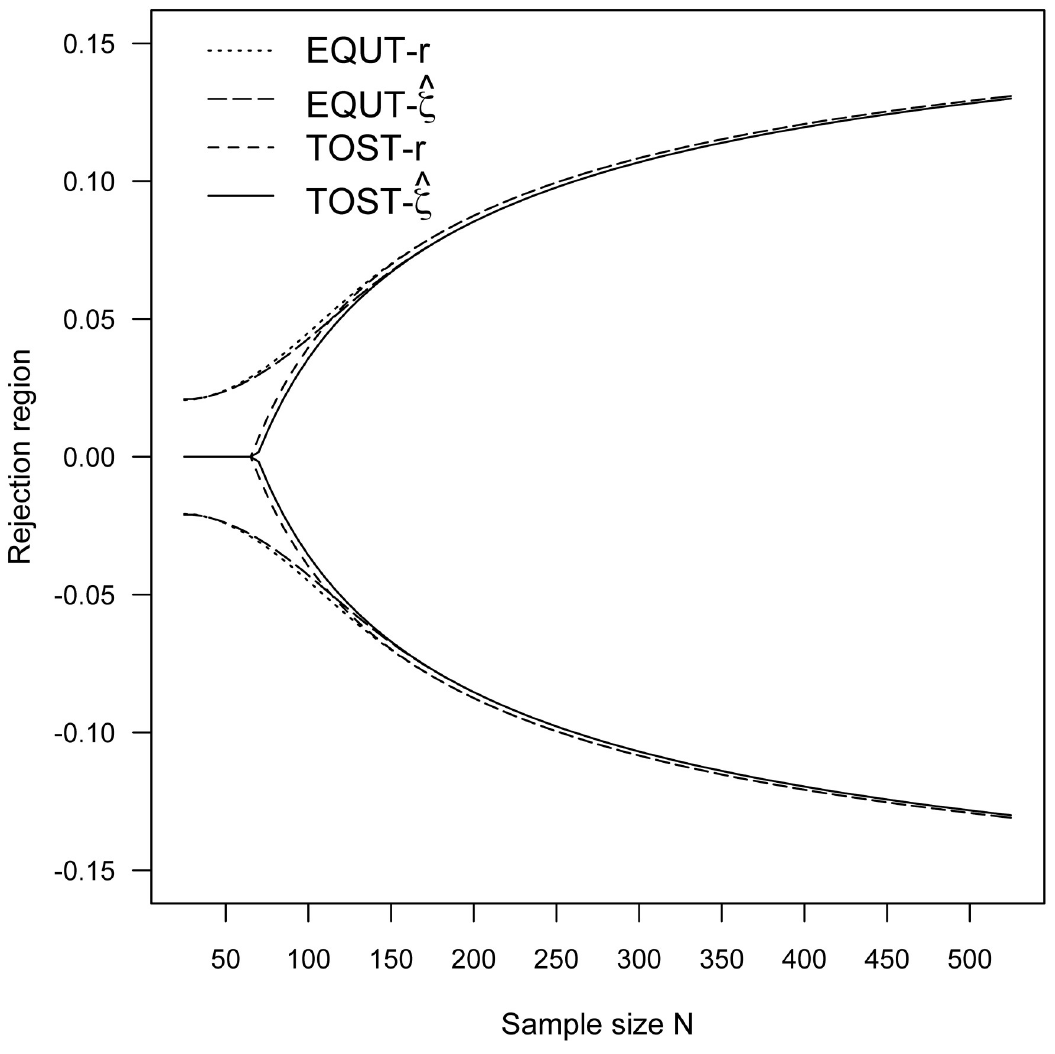
Fig 4. The rejection regions for ( ρ